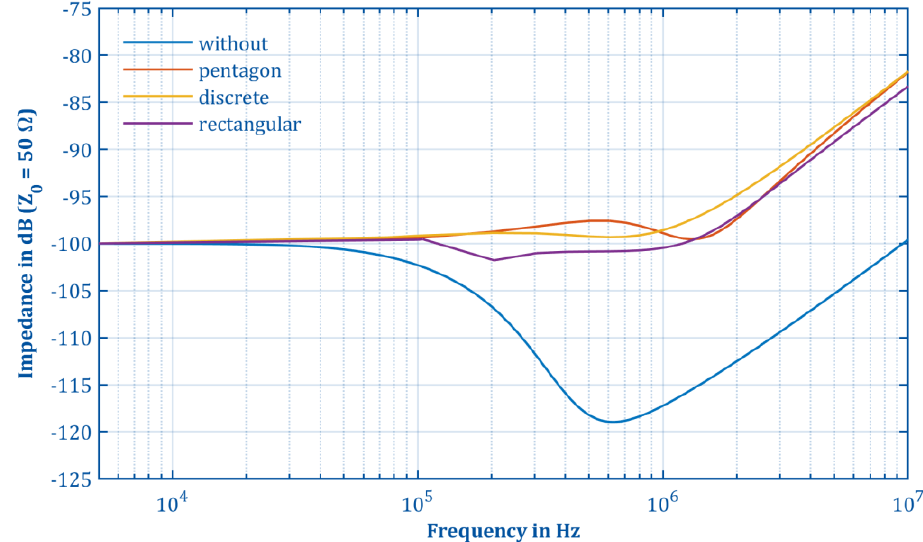
Figure 6. Simulated transmission responses for the three different compensation electrode geome- tries shown in Figure 4 compared to a PCB without compensation